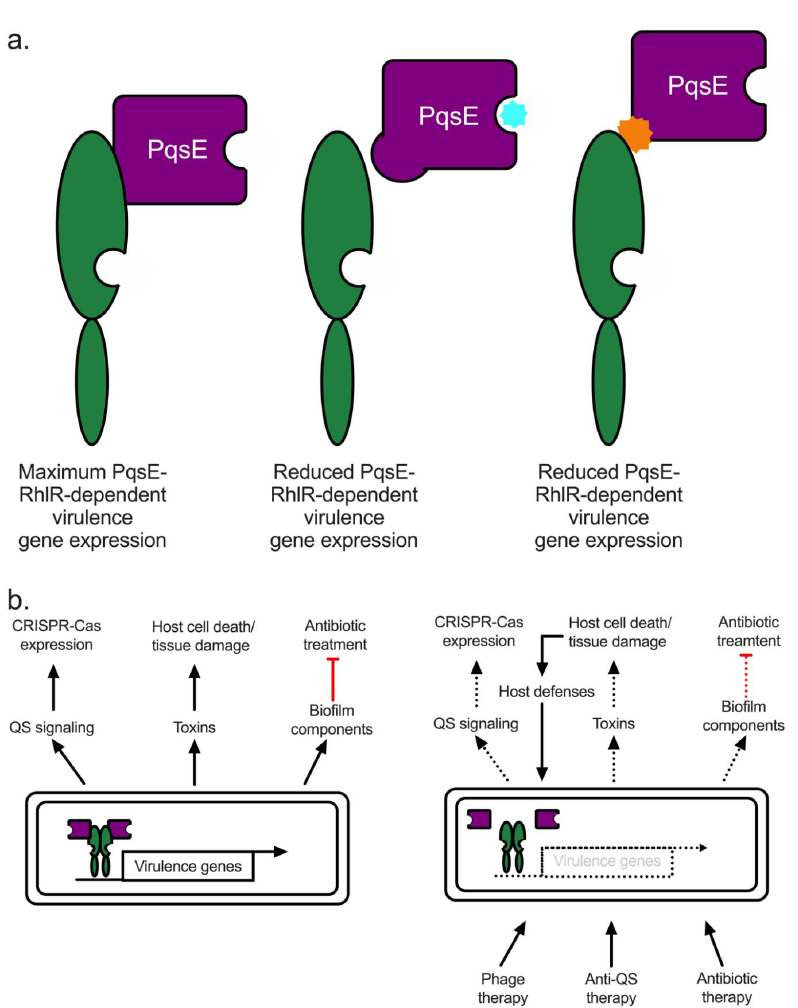
Figure 3. The future of anti-infective therapeutics to treat P. aeruginosa infections. ( a ) Schematic representation of how disrupting the PqsE-RhlR interaction could affect RhlR-dependent transcription. An inhibitor that binds in the catalytic pocket could disrupt the PqsE-RhlR interface by allostery (middle) or via a direct perturbation of the buried surface area between PqsE and RhlR (right). ( b ) Flow chart detailing how combinatorial treatment with phage therapy, anti-QS therapy, and antibiotic therapy could enhance the efficacy of each individual therapy, creating a new viable option for the treatment of antibiotic- resistant bacteria.